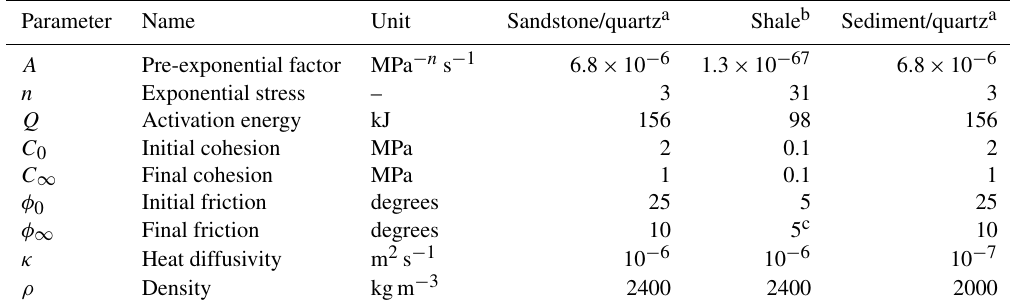
Table 1. Variable rheological parameters and coefficients for the different lithologies; creep parameters a from Ranalli and Murphy (1987) and b from Shea and Kronenberg (1992). c In models M13 to M15 the friction in the shale is temperature dependent. Parameter